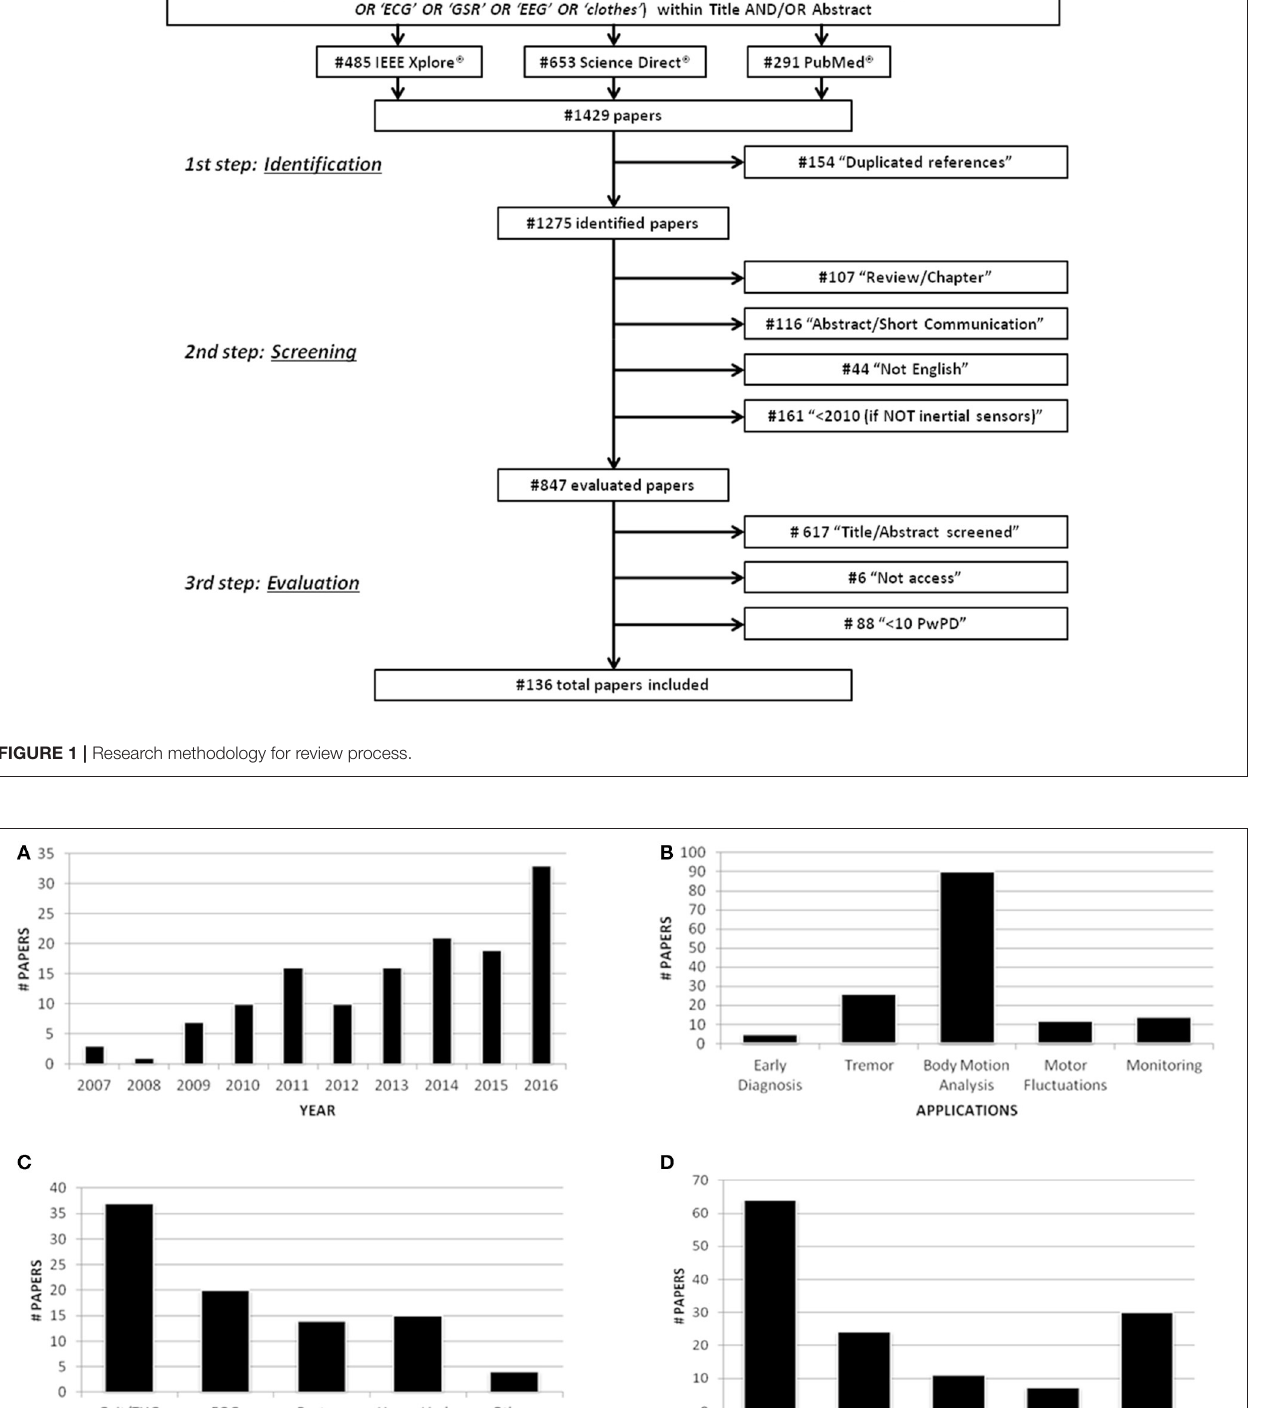
Frontiers in Neuroscience |